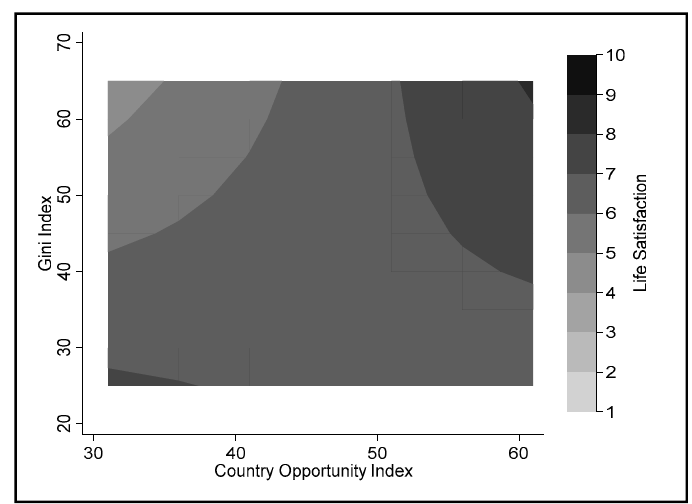
Figure 3. Interaction e ff ect of the Gini index and the Opportunity Index on life satisfaction, source: based on estimates of model 4 in Table 1.